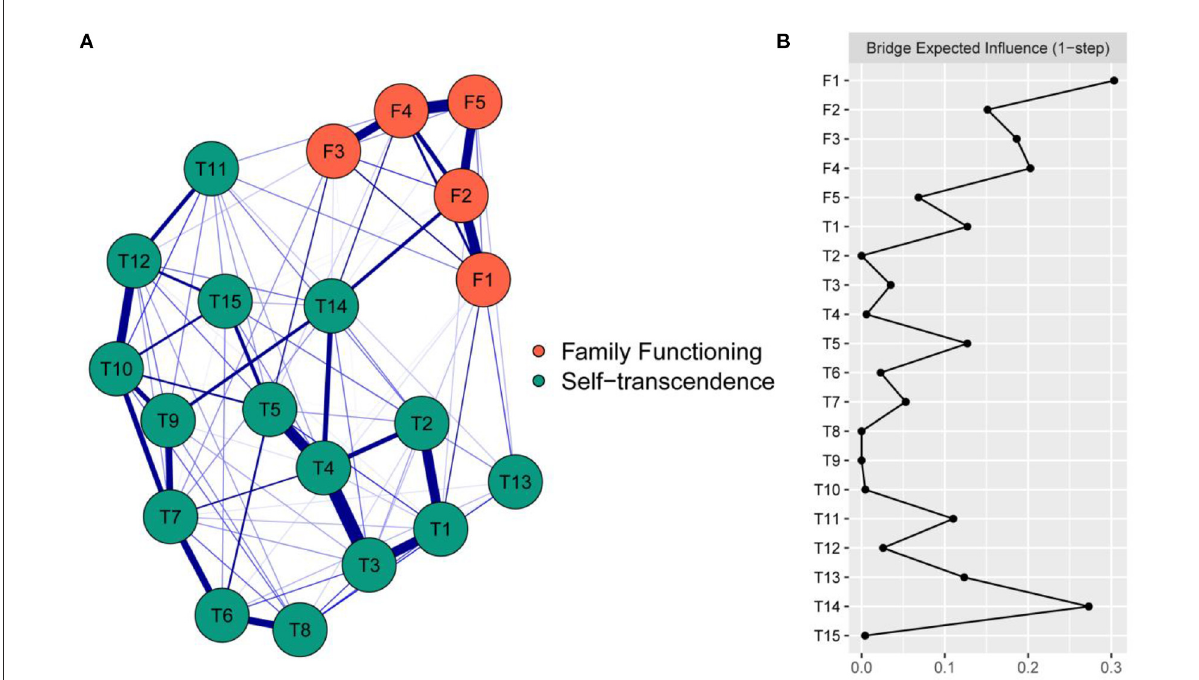
FIGURE1 The network model of family functioning and self-transcendence and the bridge expected influence. (A) The network model of family functioning and self-transcendence. The nodes represent items of family functioning and self-transcendence, the blue edges represent connections between items, and thick lines and saturated colors represent close connections. In cross-community edges, the strongest correlation of F1 was with T1, the strongest correlation of F2 was with T14, the strongest correlation of F3 was with T5, the strongest correlation of F4 was with T14, the strongest correlation of F5 was with T13. (B) The bridge expected influence indices in the network of family functioning and self-transcendence (raw score). F1 had the highest bridge expected influence value (0.30) in the family functioning community, while T14 had the highest bridge expected influence value (0.27) in the self-transcendence community. F1 = adaptation; F2 = participation; F3 = growth; F4 = affection; F5 = resolution; T1 = enjoyment of hobbies; T2 = acceptance of aging; T3 = involvement with people; T4 = adjustment to life; T5 = acceptance of bodily changes; T6 = experience sharing; T7 = meaning of the past; T8 = helping others; T9 = interest in learning; T10 = problem solving; T11 = death acceptance; T12 = meaning in faith; T13 = help acceptance; T14 = life enjoyment; T15 = letting go of the